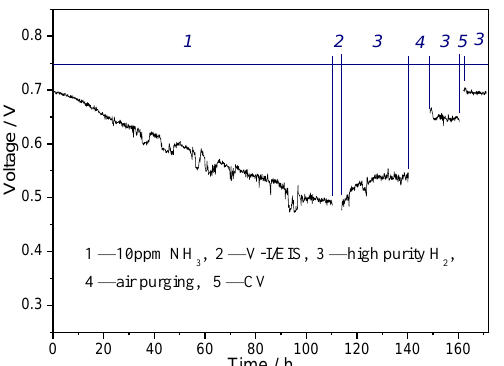
Figure 6. Recovery of cell voltage with discharging with pure H 2 , air purging, and CV. Figure 7 shows the polarization curves after poisoning with different concentrations of